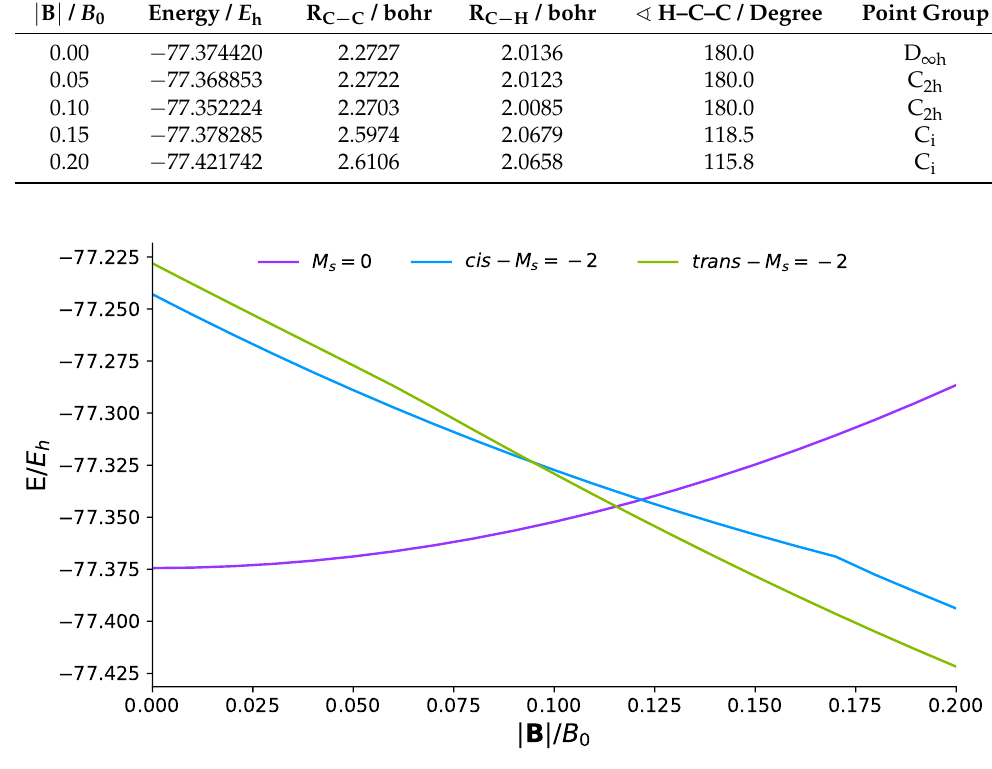
Figure 4. The energies of the optimized M s = 0, cis - M s = − 2 and trans - M s = − 2 states of the C 2 H 2 molecule with respect to the strength of magnetic field applied along the x